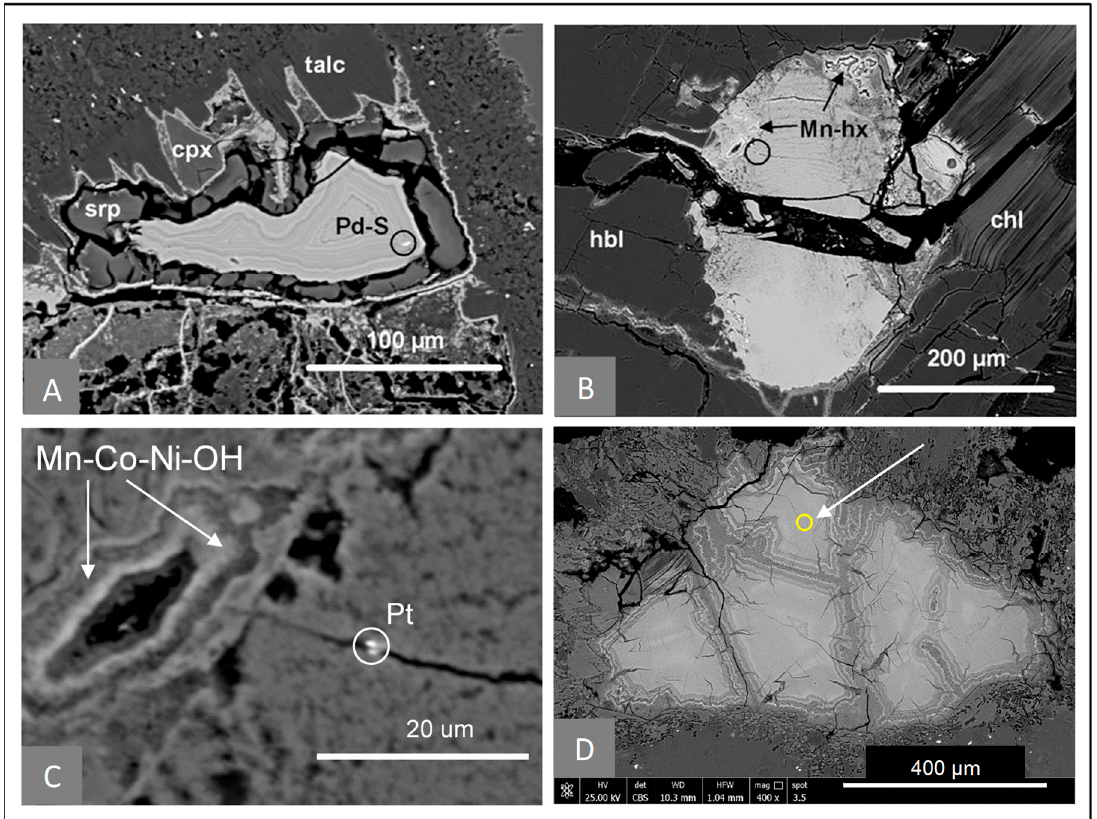
Figure 4. BSE images of secondary minerals in oxidized ores. ( A ) Iron-hydroxide with colloform texture and inclusion of Pd–S compound (circle:) in a matrix of Fe-rich serpentine (srp), talc, and clinopyroxene (cpx). The Fe-hydroxide carries 30 ppm Pt. AS 6828, Mimosa Mine. ( B ) Iron-hydroxide aggregate enclosed by chlorite (chl) and “hornblende” (hbl). Within the Fe-hydroxide, small areas and veinlets of Mn–Co-hydroxide (Mn–hx) carry 150–400 ppm Pt. Small PGM (Pt) in circle. The chlorite is rich in Ni and Cu (up to 4 and 6 wt %, resp.). AS 5320a, Mimosa Mine. ( C ) Porous Fe-hydroxide (matrix) with areas of Mn–Co–Ni-hydroxides (Mn–Co–Ni–OH) which contain ~200 ppm Pt. Small spec of PGM (Pt) in fracture. Ngezi Mine. ( D ) Interstitial iron-hydroxide with colloform textures. Analyzed point (circle, arrow) has 214 ppm Pt and 192 ppm Pd. Platreef, Overysel, Mogalakwena Mine. Reproduced with permission from Malte Junge [25].